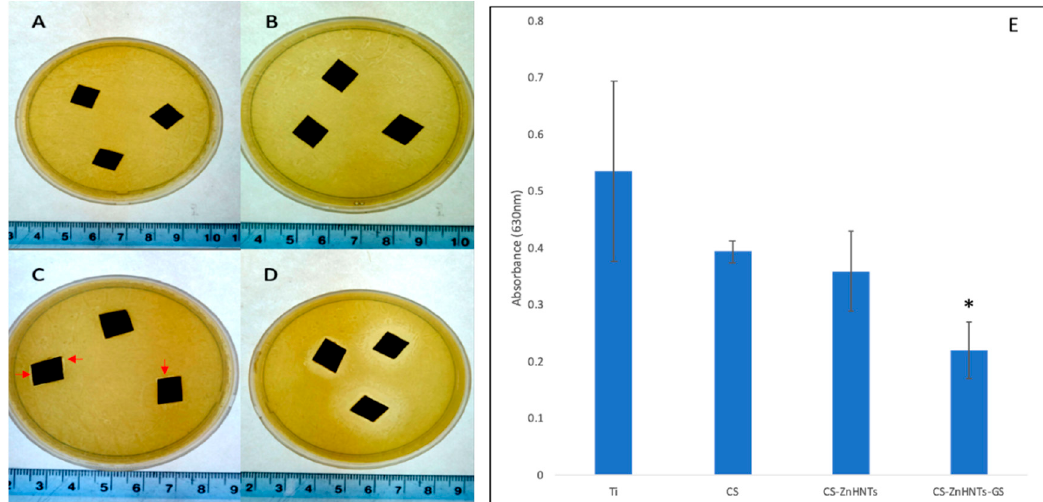
Figure 8. Disc diffusion assay for S. aureus . ( A ) CS, ( B ) HNTs-CS, ( C ) ZnHNTs-CS, and ( D ) GS- Figure 8. Disc di ff usion assay for S. aureus . ZnHNTs-CS. ( E ) Antimicrobial broth testing. GS-ZnHNTs-CS exhibited the highest bacteriostatic